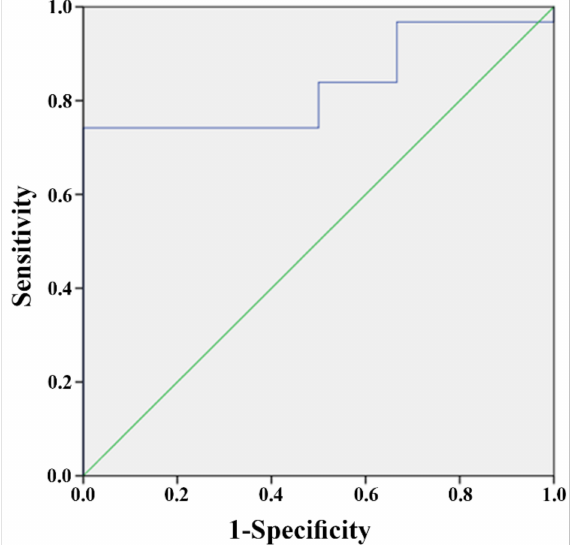
Figure 3. miR-155 can predict a patient’s outcome: ROC curve showing the predictive power of miR-155 levels measured at the time of hospitalization, to predict the patient’s outcome: survival or death (blue line). The green diagonal line represents a random classifier